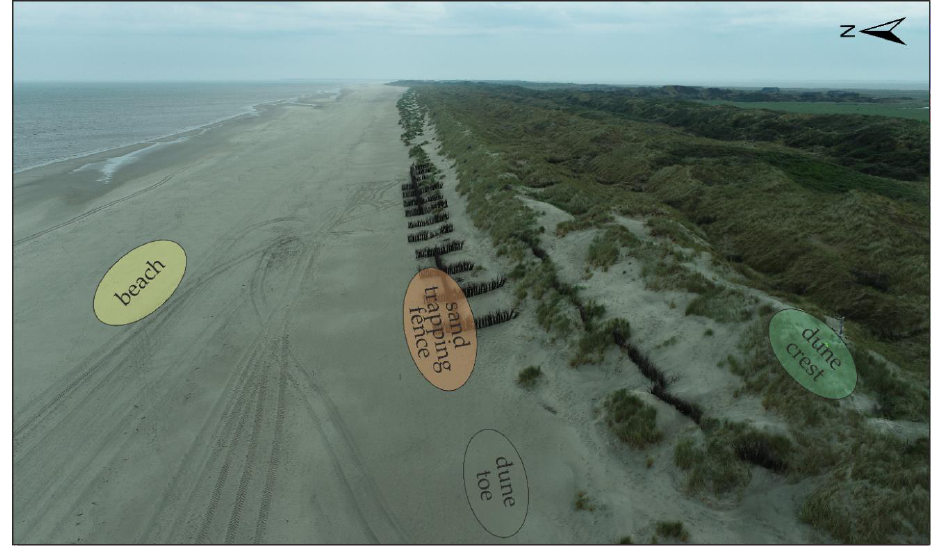
Figure 3. Overview of the different measurement locations: beach, dune toe, dune crest, and sand trapping fence at the study site Langeoog. The aerial photograph was obtained on 19 May 2020. All four measurement locations differ a lot in their prevailing boundary conditions. A closer visual impression of the locations (a) beach, (b) dune toe, (c) dune crest, and (d) sand trapping fence is given in Figure 4a.